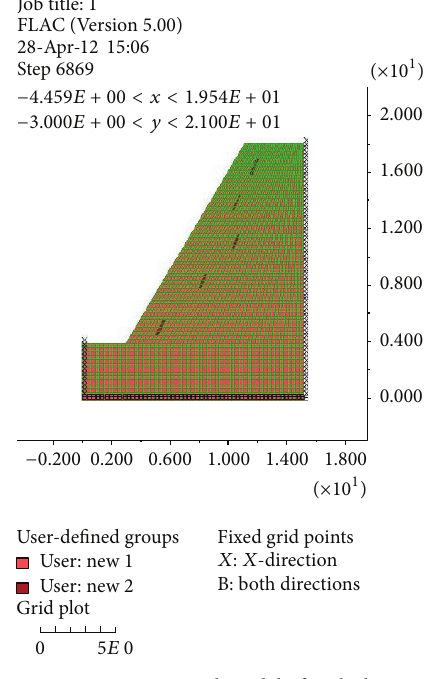
Figure 2: Numerical model of rock